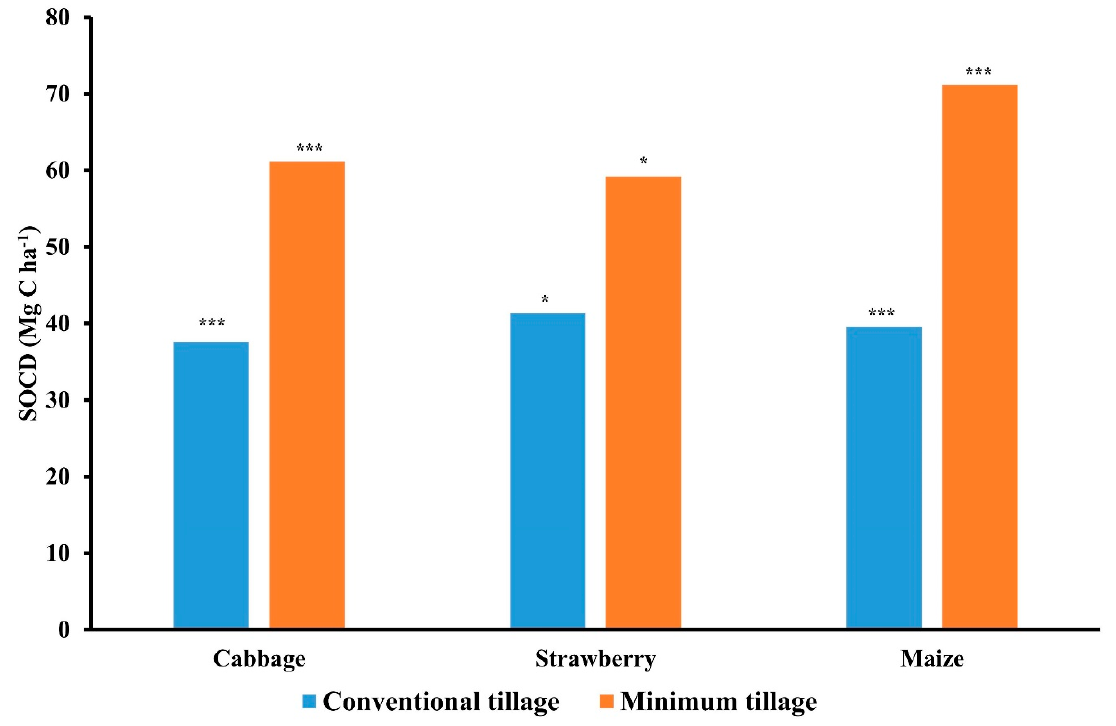
Figure 6. Comparison of top SOCD between conventional tillage and minimum tillage of cabbage, strawberry, and maize areas. *, **, *** Significant difference at 10%, 5%, and 1% level, respectively.